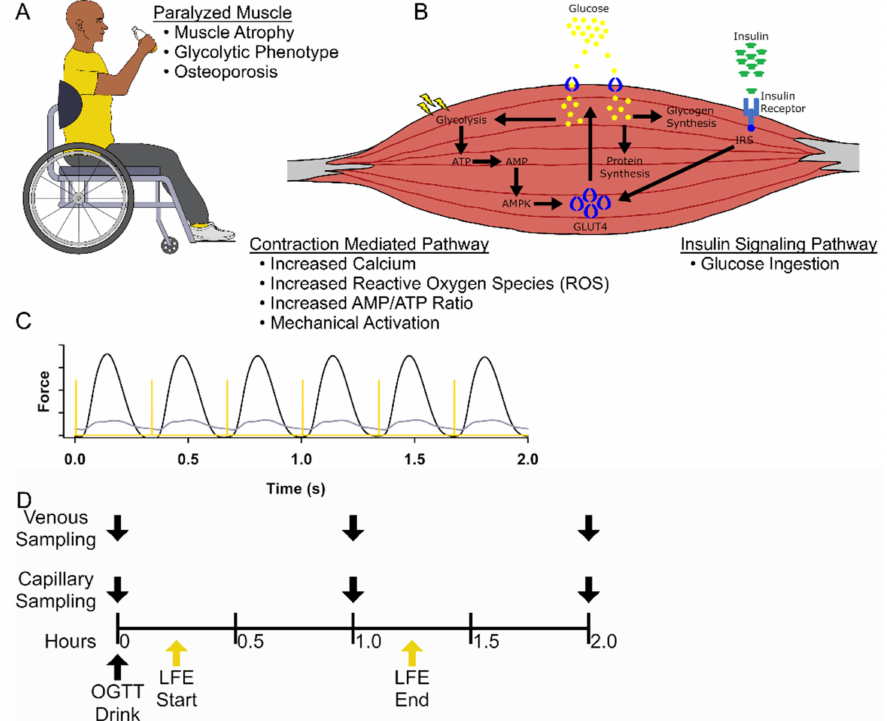
Figure 1. Schematic of experimental design. ( A ) People with a spinal cord injury (SCI) use wheelchairs to enable locomotion and increased independence; however develop osteoporosis, muscle atrophy, highly glycolytic muscle fibers that become less responsive to insulin-dependent glucose uptake, leading to a hyperinsulinemia. ( B ) Representative schematic of the mechanisms utilized by skeletal muscle to control blood glucose concentration. Our LFE bypasses the insulin-dependent mechanism to promote the translocation of GLUT4 to the sarcolemma through the activation of AMPK. ( C ) A representative example from a force tracing of quadriceps muscles at the start (black) and end (gray) of a bout of LFE with the associated stimulus pulse (yellow). ( D ) Schematic of study timeline of venous blood sampling and capillary blood sampling during the control session and the LFE session that was started 15-min after consuming a 75 g glucose